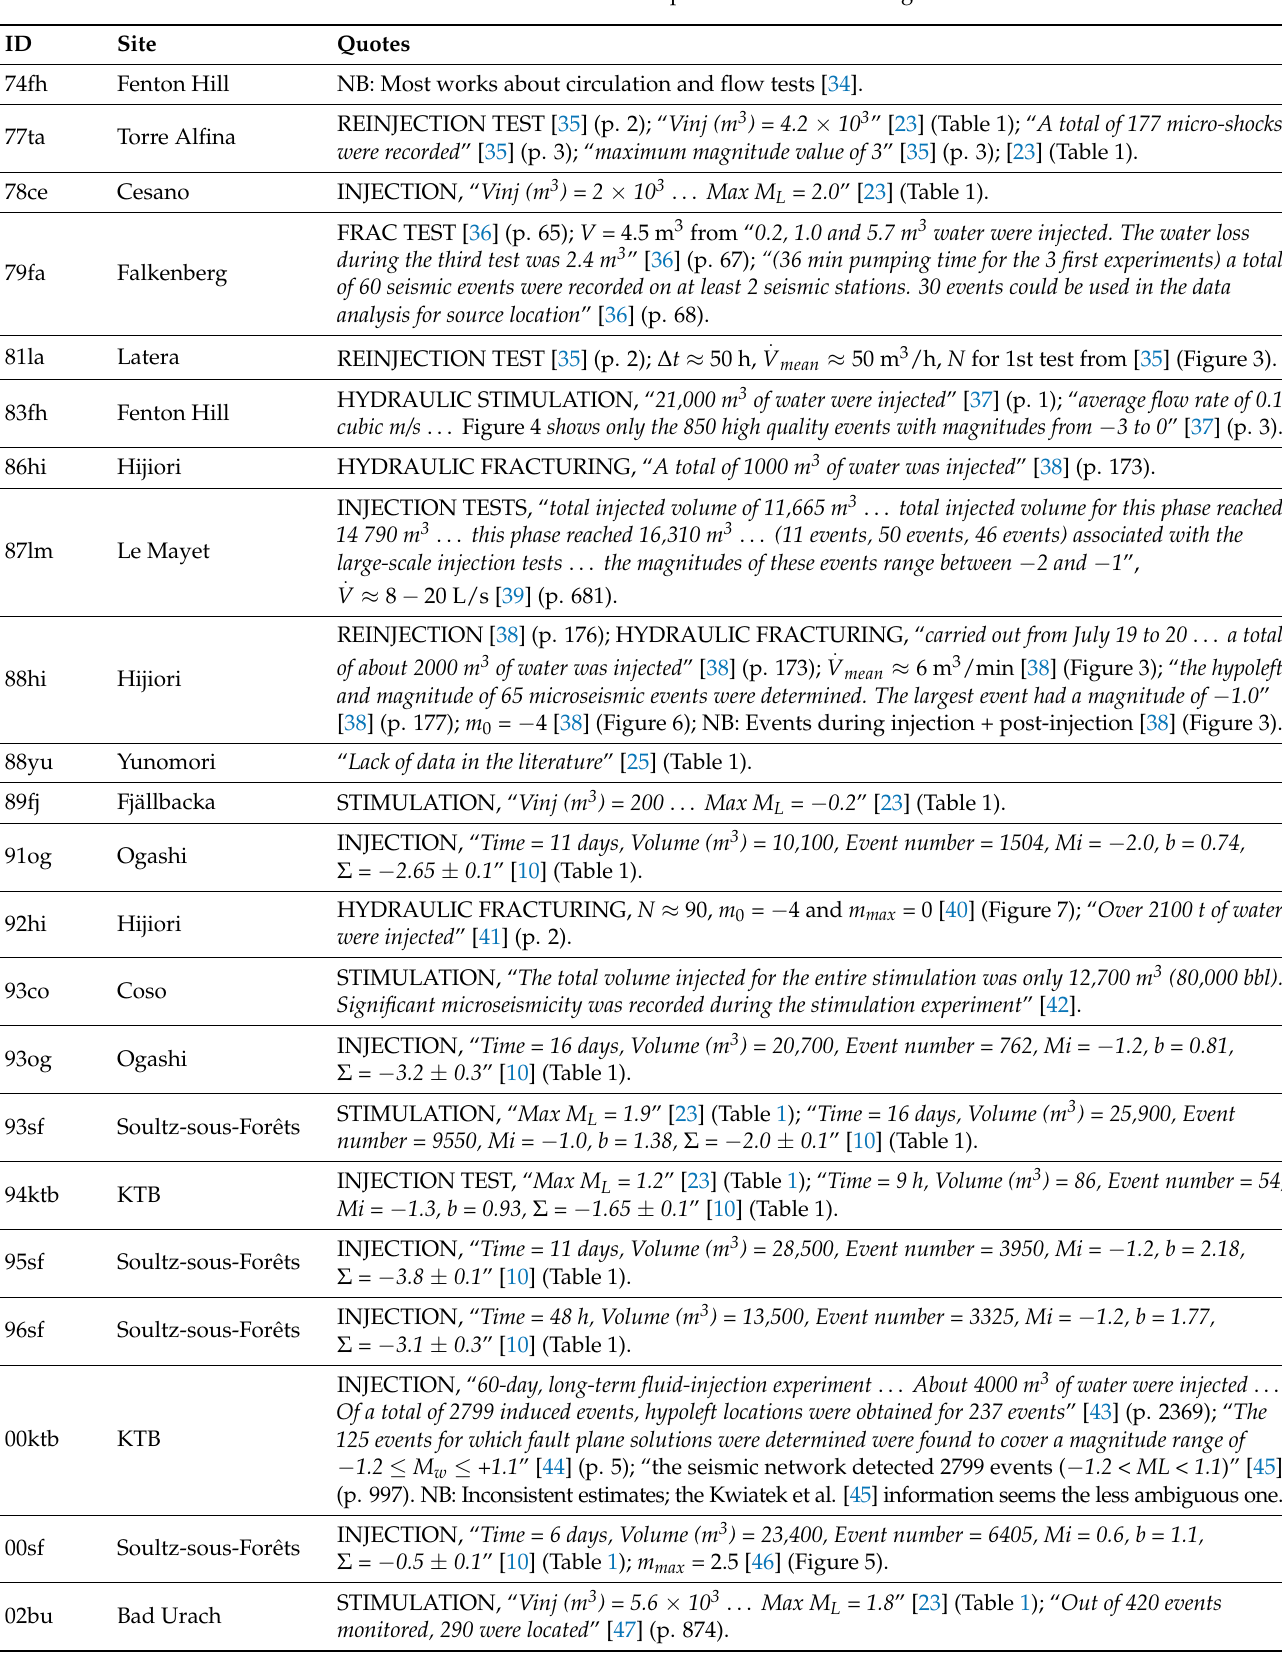
Table A1. Raw literature excerpts used for data